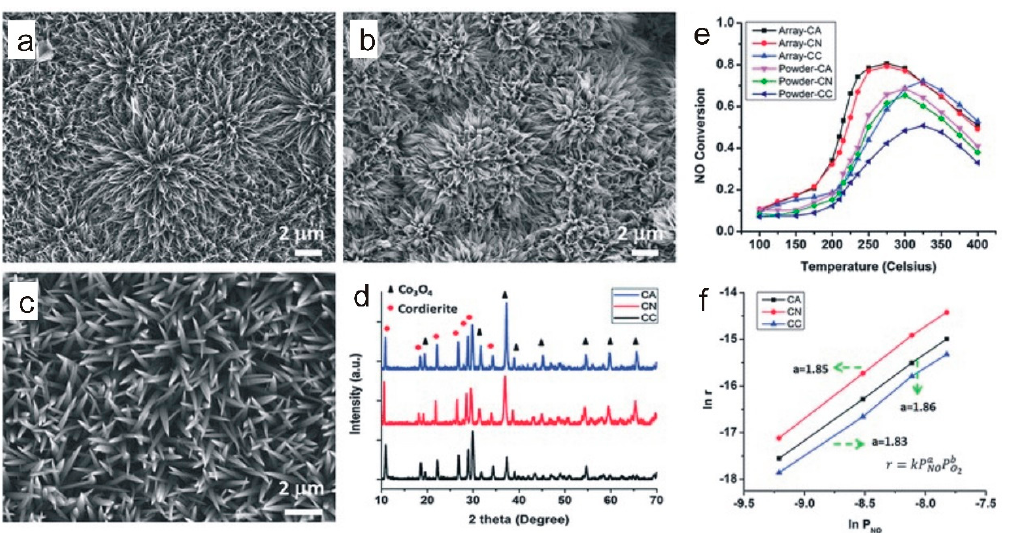
Figure 6. SEM images of Co 3 O 4 nano ‐ arrays made from ( a ) cobalt nitrate; ( b ) cobalt acetate and ( c ) cobalt chloride; ( d ) X ‐ ray diffraction patterns of Co 3 O 4 nano ‐ arrays on cordierite honeycomb substrates; ( e ) NO oxidation performance of catalytic Co 3 O 4 nano ‐ arrays and powders prepared from different precursors; ( f ) Reaction rates r NO measured at 100 °C as a function of CO or O 2 concentration over different Co 3 O 4 nanowire arrays. Reprinted with permission from [16], Copyright RSC, 2013. CA: cobalt acetate tetrahydrate; CN: cobalt nitrate hexahydrate; CC: cobalt chloride hexahydrate. intensity of primary crystal planes of Co 3 O 4 in X ‐ Ray Diffraction (XRD) patterns [16]. Samples synthesized by Co(NO 3 ) 2 ∙ 6H 2 O and Co(C 2 H 3 O 2 ) 2 ∙ 4H 2 O (CA and CN) showed similar performance